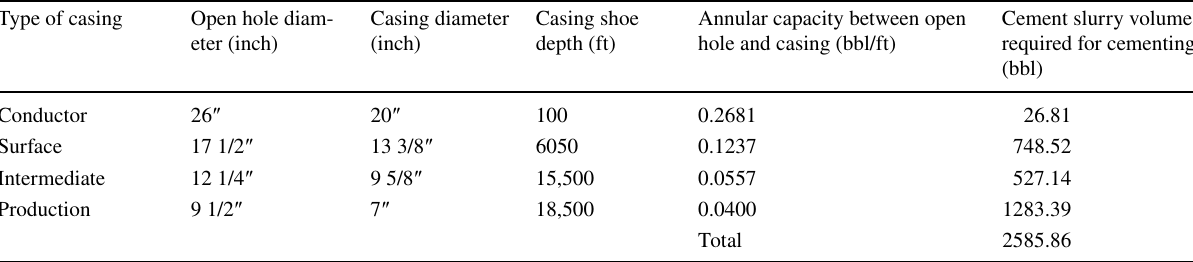
Casing diameter Casing shoe Annular capacity between open eter (inch) (inch) depth (ft) hole and casing (bbl/ft)